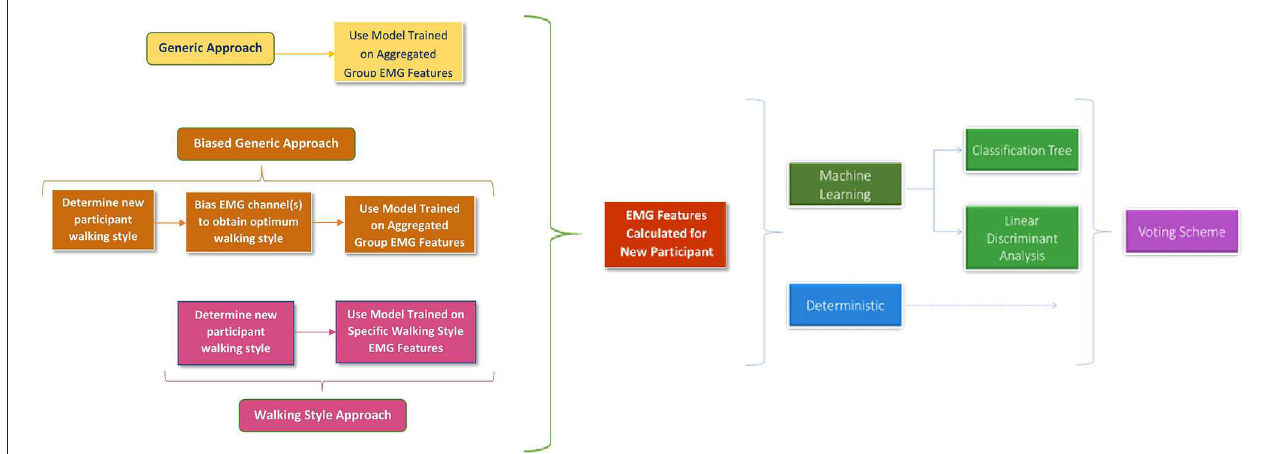
FIGURE 2 | Graphical Representation of how the Prediction Approaches and Classification Algorithms